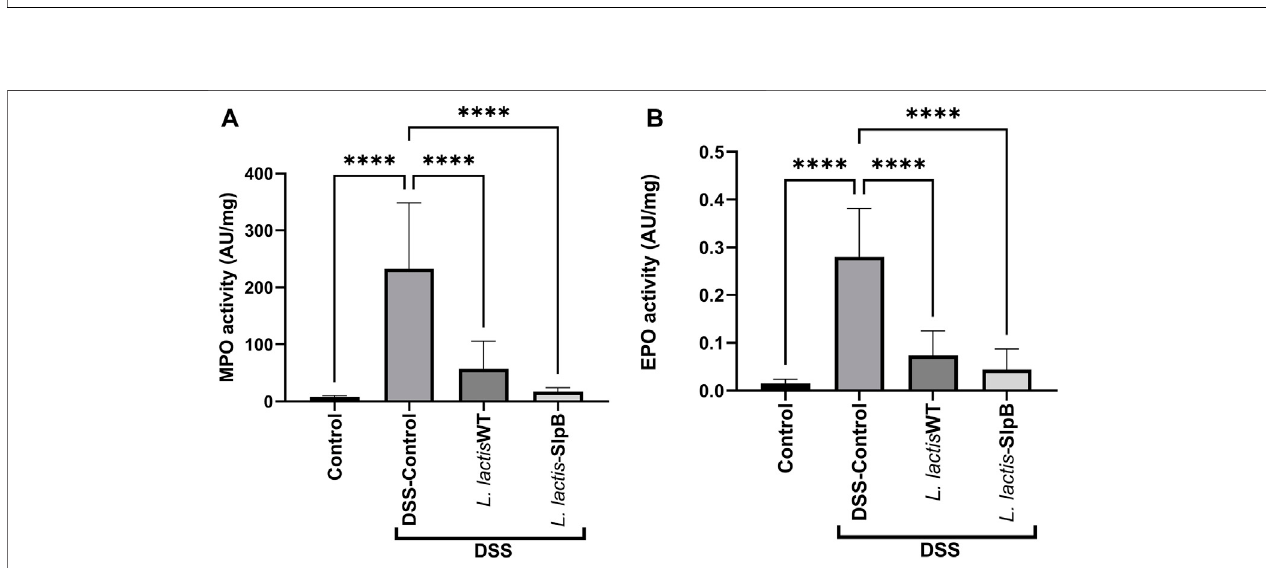
FIGURE 4 | L. lactis Wild-type and L. lactis -SlpB strains prevent DSS-induced increase of myeloperoxidase (MPO) and eosinophilic peroxidase (EPO) activity. Quanti fi cation of the myeloperoxidase [MPO, (A) ] and eosinophilic [EPO, (B) ] enzymes in the colon tissue is shown. One-way ANOVA and Tukey ’ s post - hoc tests were used for multiple comparisons. The data represent the mean ± SD of six mice per group. Asterisks represent statistically signi fi cant differences as follows: p p < 0.05, pp p < 0.01, ppp p < 0.001, pppp p < 0.0001.